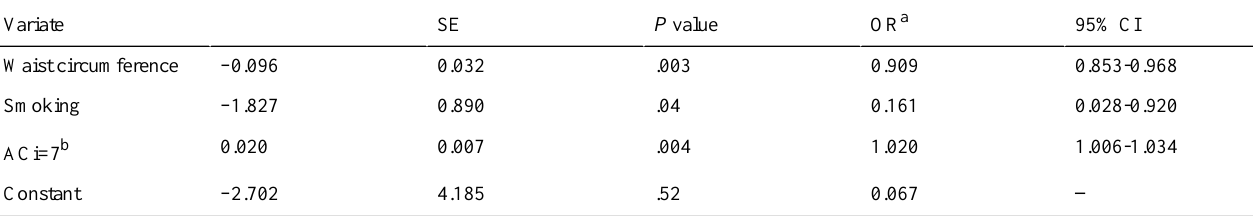
Table 3. Physical predictors of 3000-meter running qualification (multivariate logistic regression).